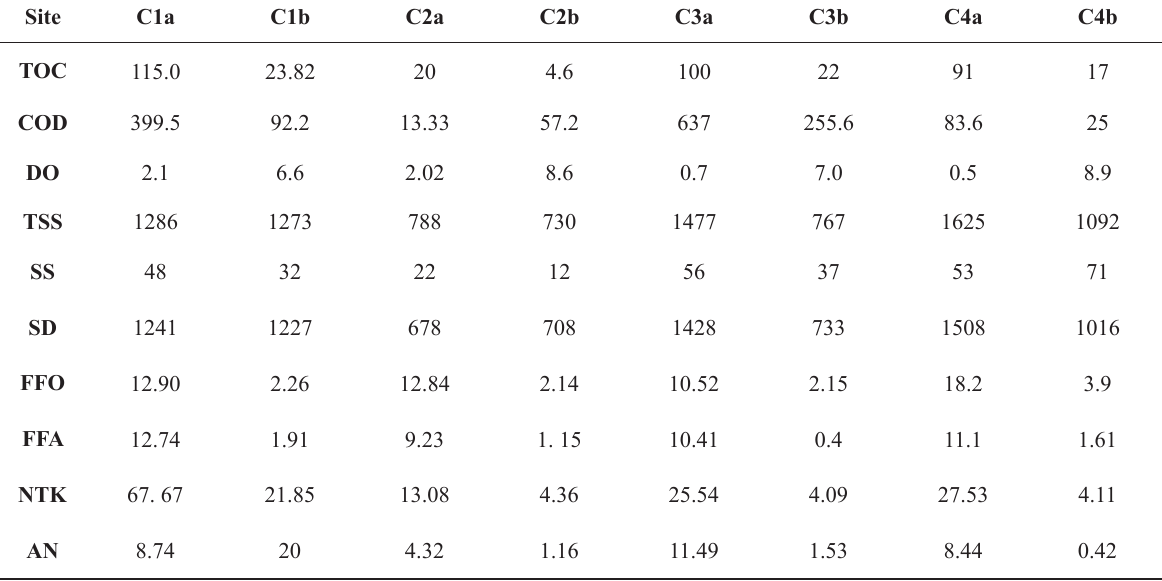
Physicochemical parameters observed in samples collected from the Wastewater Treatment